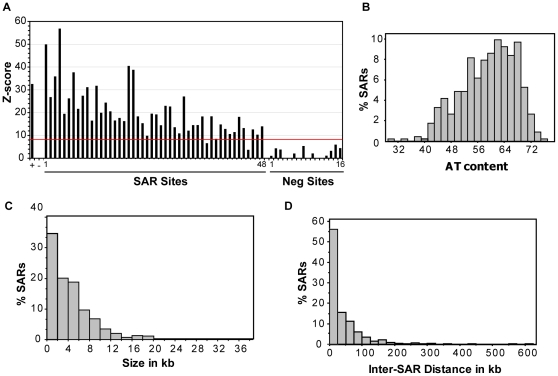
Validation of microarray results and SAR characteristics.A.) Summary of qPCR validation for 48 identified SARs and 16 negative regions chosen from the microarray data. The average enrichment in the scaffold fraction relative to total genomic DNA was normalized to the ApoB negative control by calculating Z scores (+ indicates ApoB 3′MAR positive control, − indicates ApoB negative control). 96% of the sites tested validated with a Z score corresponding to ≥8 standard deviations away from the negative control. B.) Histogram of SAR AT content. C.) Histogram of SAR size plotted in 2 kb bins. D.) Histogram of inter-SAR distance plotted in 25 kb bins.